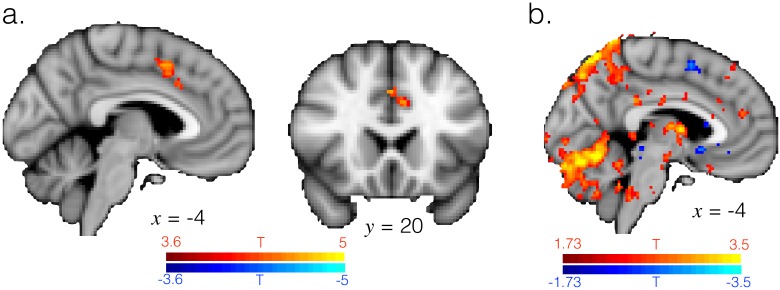
ACC is engaged when transitioning from exploitation to exploration.(a) T-statistic maps for the regressor for switching from exploitation to exploration, as in GLM2 (note this is variance explained by the regressor over and above that explained by the other regressors in GLM2, such as changing response and reward). Image thresholding at p<0.001; corrected for multiple comparisons. (b) T-statistic map at a more liberal threshold of p<0.05, voxelwise and uncorrected, for the regressor for switching from exploration to exploitation, showing this transition does not engage ACC. Hence ACC transition-related activity appears to be specific for switching from exploitation to exploration and not vice versa.